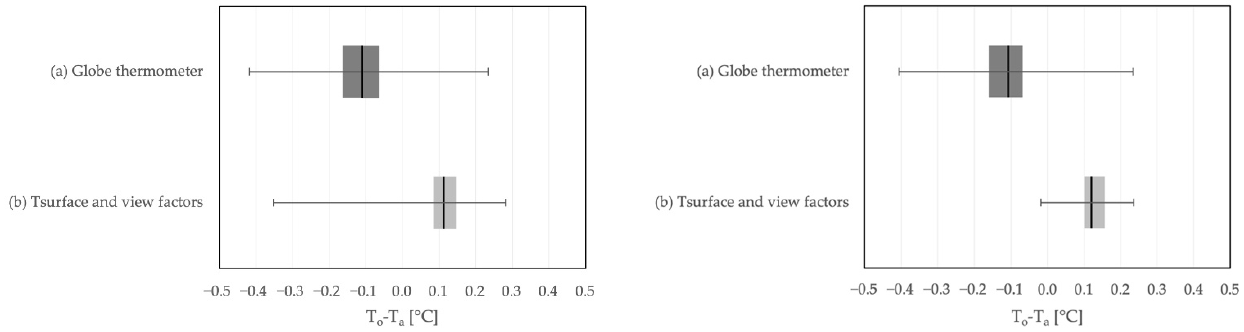
Figure 7. Relative temperature difference ∆ T = T op − T a considering ( a ) the operative temperature T op,g , calculated considering the mean radiant temperature obtained through the use of the globe thermometer and ( b ) the operative temperature T op,s , calculated using the mean radiant temperature calculated from measured values of the temperature of the internal surfaces of the surrounding walls, their area, and their view factor. The image on the left is referred to the entire test, the right one considers only the discharge phase. The box represents the interquartile range (i.e., 25th–75th percentiles) and the whiskers represent the minimum and the maximum.